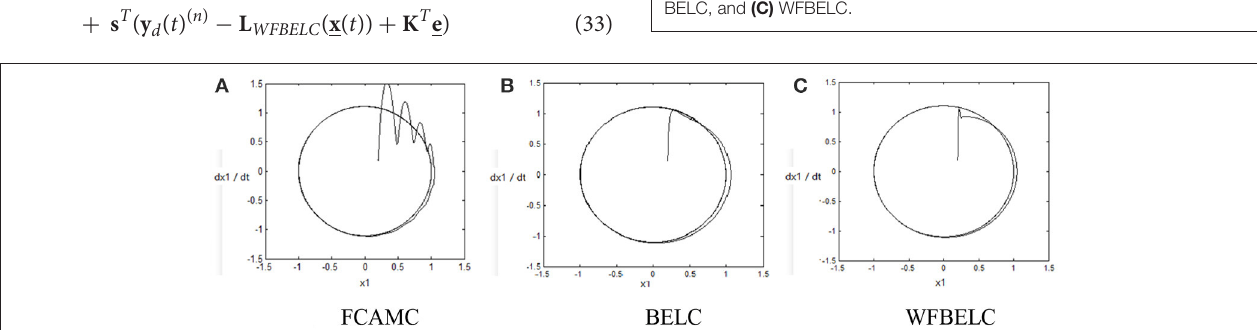
FIGURE 4 | Periodic orbit phase plane plots ( q = 0.3) (A) FCAMC, (B) BELC, and (C) WFBELC.